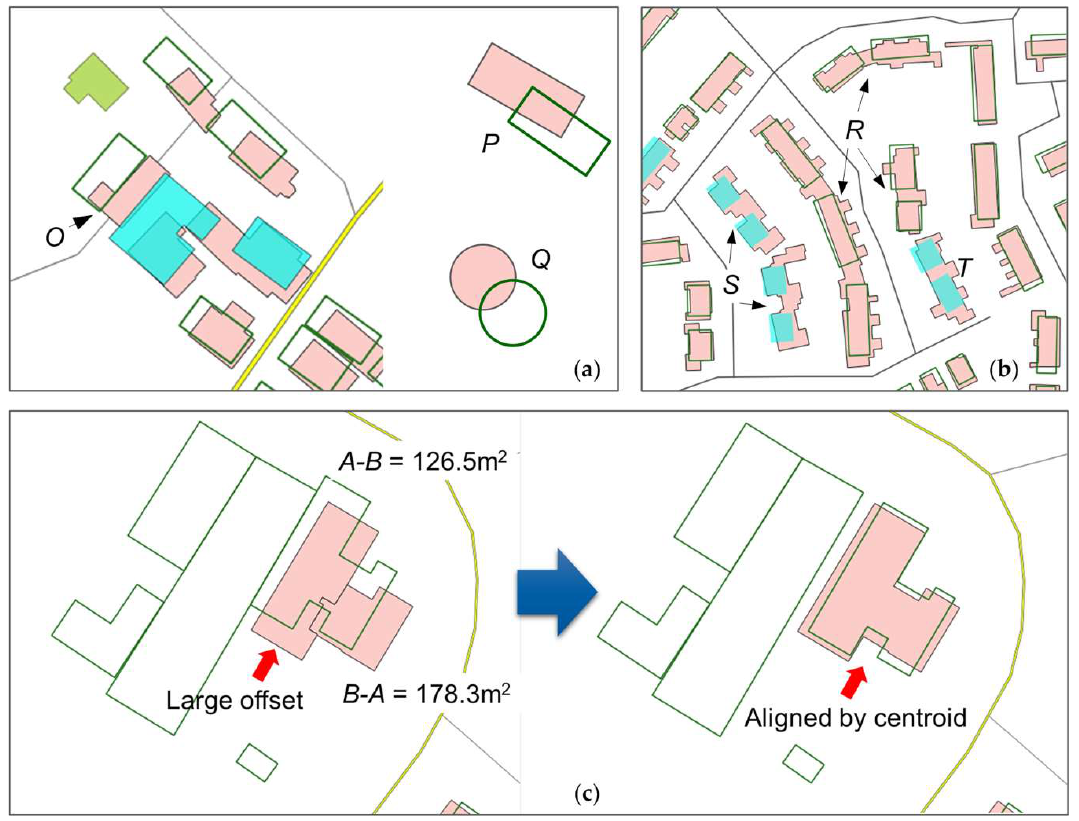
Figure 12. Effectiveness of the use of ( a ) ‘CommonAreaRatio’ in data matching, ( b ) ‘AggRatio’ in merging the m -to- n relation, and ( c ) controlled alignment in our change detection approach.